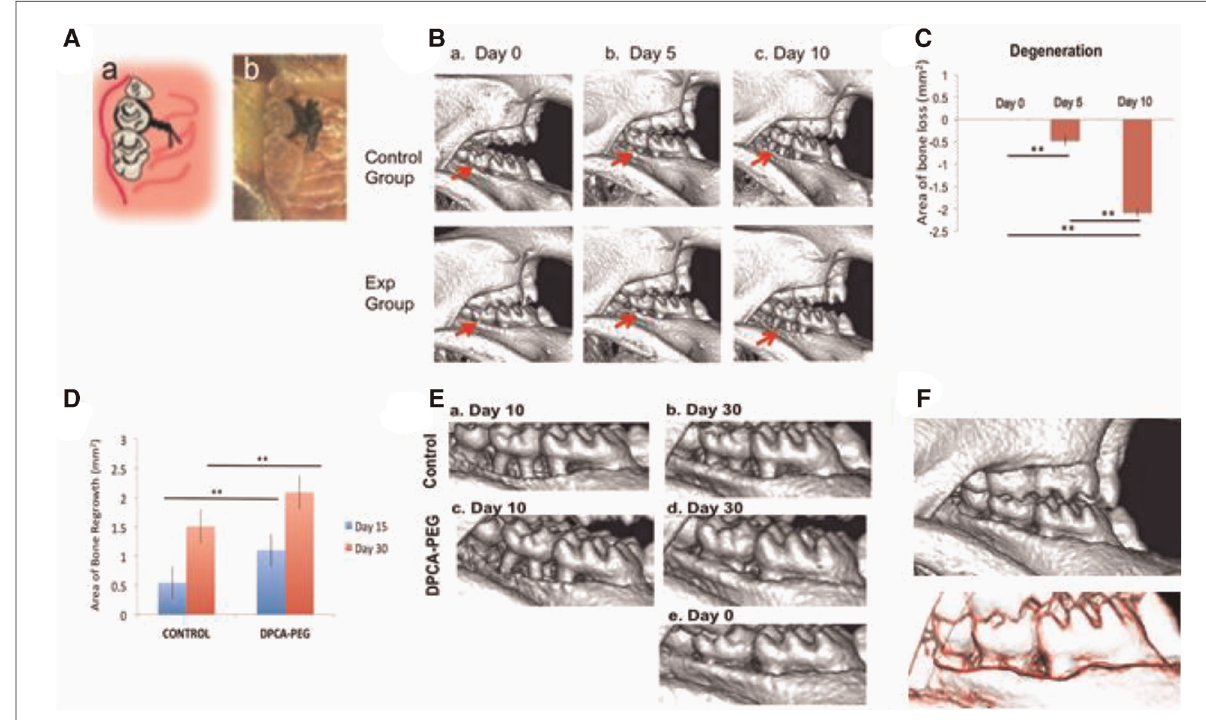
FIGURE 1 Degeneration of the mouse jawbone in the presence of ligature followed by regeneration of the jawbone post-ligature and post-drug. ( Aab ) The ligature-induced periodontitis model. 5 – 0 silk suture was passed through the interdentium between the maxillary fi rst molar, the second molar and third molar using Dumont forceps. Suture was tied fi rmly using a triple-knot and excess suture was cut using spring scissors as seen in the cartoon ( a ) and photomicrograph ( b ). Taken from Ref. (31). ( Ba – c ) Micro-CT scans of jaws from mice during the 10 day ligature period for days 0, 5, and 10. The control group image is representative of the group ( n =3) that will not receive drug (control, upper row) and the experimental group image is representative of the group ( n =3) that will receive drug (experimental, lower row). The red arrows show the maxillary left second molars with bone degeneration extending to the adjacent 1st and 3rd molars. For visual clarity, the images are inverted 180 degrees (now: mandible top, maxilla bottom). ( C ) The area of degeneration was determined for all animals tested and shown for day 5 and day 10 after ligature placement. The y -axis is: Area of bone loss (mm 2 ); ( n =7); error bars represent standard errors; for days 0 – 5, p =0.00289; for days 0 – 10, p = 7.33084×10 − 11 ; and for days 5 – 10, p =3.60818×10 − 7 . (**) Represents p <0.01. In ( D ), a graph of area of bone growth is seen for mice post – ligature but not given drug (no drug control) vs. mice given drug (DPCA-PEG). Mice were injected with DPCA-PEG subcutaneously on days 0 and 8 after ligature placement and removal. MicroCT scans were obtained on day 15 of the experiment (day 5 post-ligature) and on day 30 (day 20 post-ligature). Here, a statistical analysis of the area of bone growth (mm 2 ) is seen. Signi fi cant differences are found between the no drug control mice ( n =10) and DPCA-PEG-treated mice ( p =0.00253) on day 15 (blue bars) ( n =12). The same is true on day 30, where DPCA-PEG- treated mice showed highly signi fi cant differences from non-drug-treated controls ( p =0.00612) (red bars). Area analysis was performed as described in the Materials and Methods. The Y -axis=Area of bone regrowth (mm 2 ); the error bars represent standard errors; and p values are represented as (*)= p <0.05; (**)= p <0.01. Mouse jaws analyzed were n =10 for ligature, no drug; n =12 for ligature/plus drug. In ( E ) micro-CT data shows a representative mouse maxilla which had ligature removed at day 10, scanned on day 10 and then re-scanned on day 30 ( Ea,b ) as compared to a representative mouse maxilla receiving ligature and DPCA-PEG drug seen on day 10 and day 30 ( Ec,d ). The level of regrowth in the drug-treated group shows an almost, if not complete, return to what is seen before the start of the experiment (da0) ( Ed,e ). In ( F ), there was no change in bone histology approximately 6 months later. Mice injected with DPCA-PEG drug were kept for additional observation as they aged. Over six months after the da 30 scan, mice were rescanned (upper panel) and then compared to the day 30 scan by overlaying the two scans on da 30 and da 220 (lower panel). The black line is the da 30 scan and the red line is the da 220 scan. Though shown as two lines, they are exactly overlapping. This result is representative of three